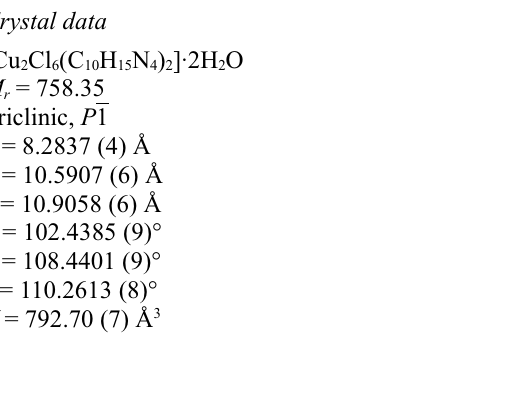
Figure 2 Packing of I viewed down the c axis, with O—H···Cl bonds connecting the dimeric units. Di- µ -chlorido-bis[dichlorido(3,3 ′ ,5,5 ′ - tetramethyl-4,4 ′ -bipyrazol-1-ium- κ N 2 ′ )copper(II)]